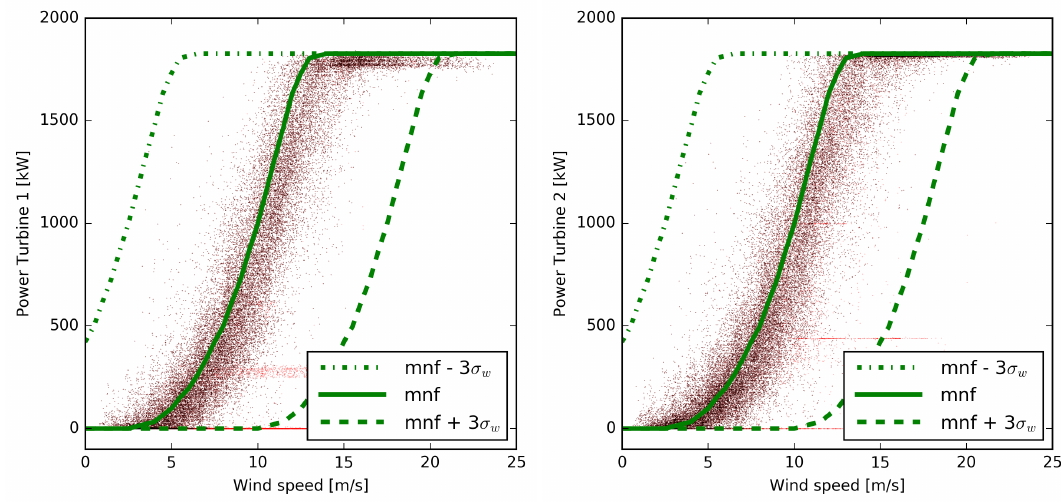
Figure 3. Turbine 1 ( left ) and 2 ( right ) power measurements as a function of the ECMWF operating model wind speed forecast, at 100 m, for forecasting times up to +48 h. Red dots show all available measurements, and black dots the measurements after the filtering on the basis of the plant operator’s directions. The solid curve represents the manufacturer’s power curve (mnf), the same power curve translated to account for the wind forecast error is plotted